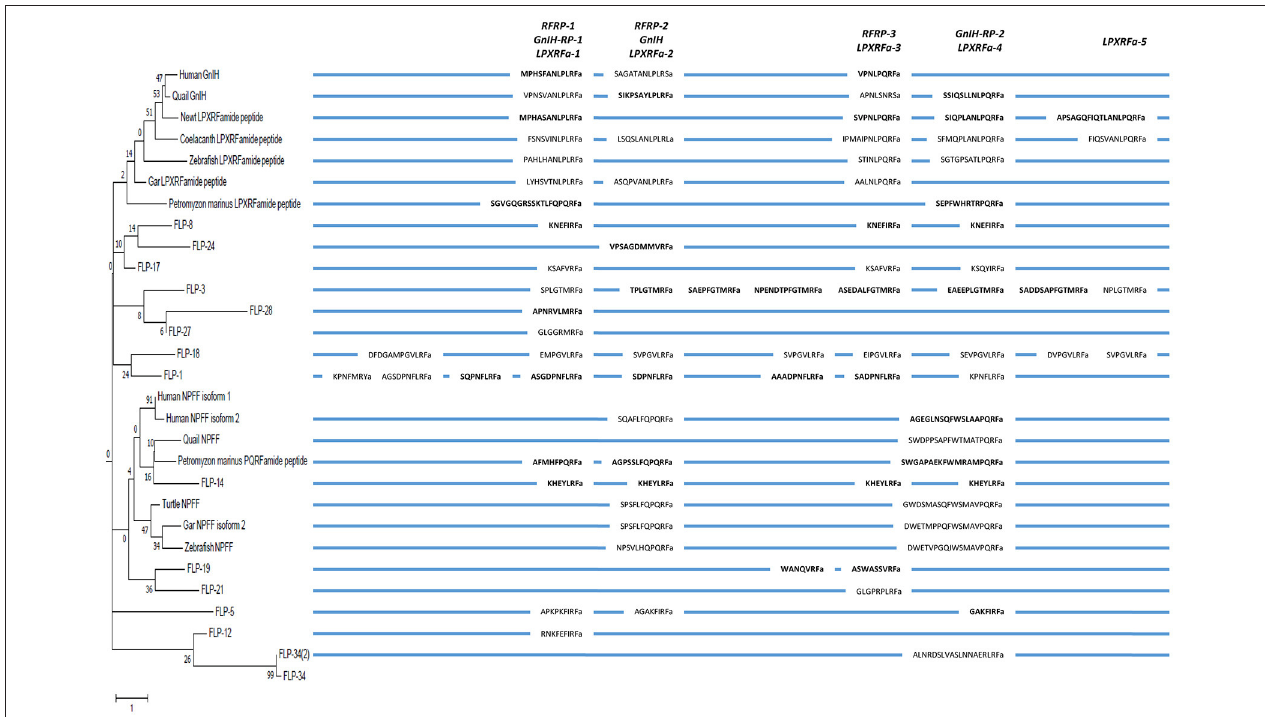
FIGURE 6 | A schematic representation of the multiple sequence alignment of human, quail, newt, coelacanth, zebrafish, gar, lamprey GnIH, human, quail, turtle, zebrafish, gar, lamprey NPFF, and C. elegans FMRFamide-like peptide (FLP) precursors highlighting the sequences of identified and predicted biologically active peptides. Each precursor is shown next to the branch of the partial phylogenetic tree of human, quail, newt, coelacanth, zebrafish, gar, lamprey, amphioxus GnIH, human, quail, turtle, zebrafish, gar, lamprey, amphioxus NPFF, fruit fly FMRFamide and C. elegans FLP precursors ( Figure 3 ). Note that the alignment of the peptides is based on multiple sequence alignment of all precursors ( Supplementary Figure 2 ). Therefore, human NPSF (NPFF) is aligned to human RFRP-2 instead of human RFRP-1 ( Figure 2 ).